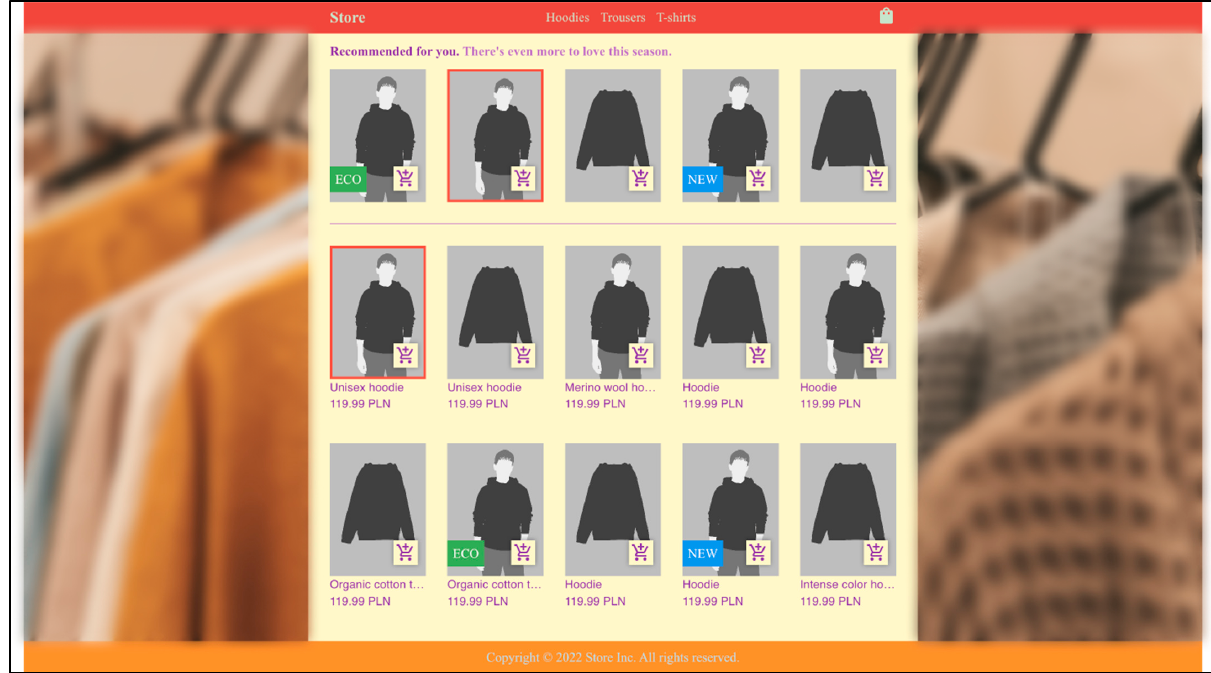
Figure 4. Aesthetic store’s website appearance. Color palette: modern gray and white palette, single-color background. Product photos: height-to-width ratio 1.618 (golden ratio), modern-looking rounded corners, smooth animation after hovering over with mouse cursor. Text: readable font colors, very dark gray on very light gray and vice versa. Distance between elements: short distances consistent with the rest of the interface. (The pictures of clothes and models are illustrative).